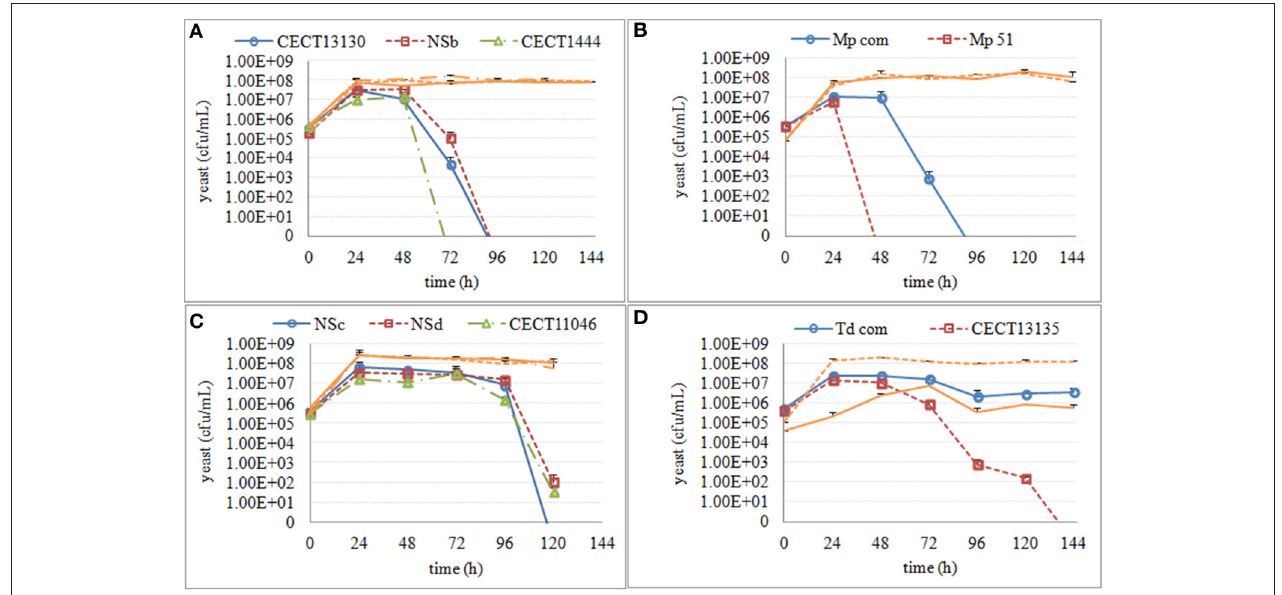
FIGURE 2 | Culturable population of non- Saccharomyces in mixed fermentations with S. cerevisiae . Culturable S. cerevisiae populations were shown in orange line using the same line type as the non- Saccharomyces co-inoculated. (A) H. uvarum (B) M. pulcherrima (C) S. bacillaris (D) T. delbrueckii.